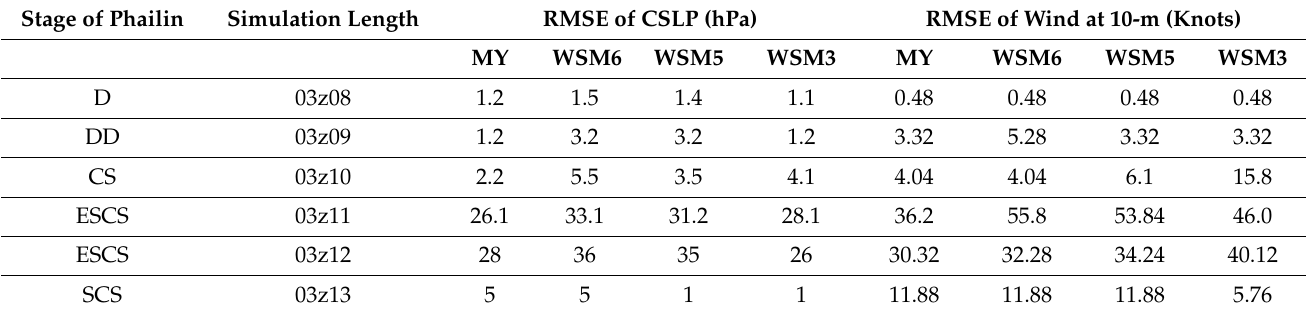
Table 4. The 24-h average RMSE of CSLP (hPa) and MSW (knots) for the Phailin cyclone derived from D02 experiments. Stage of Phailin Simulation